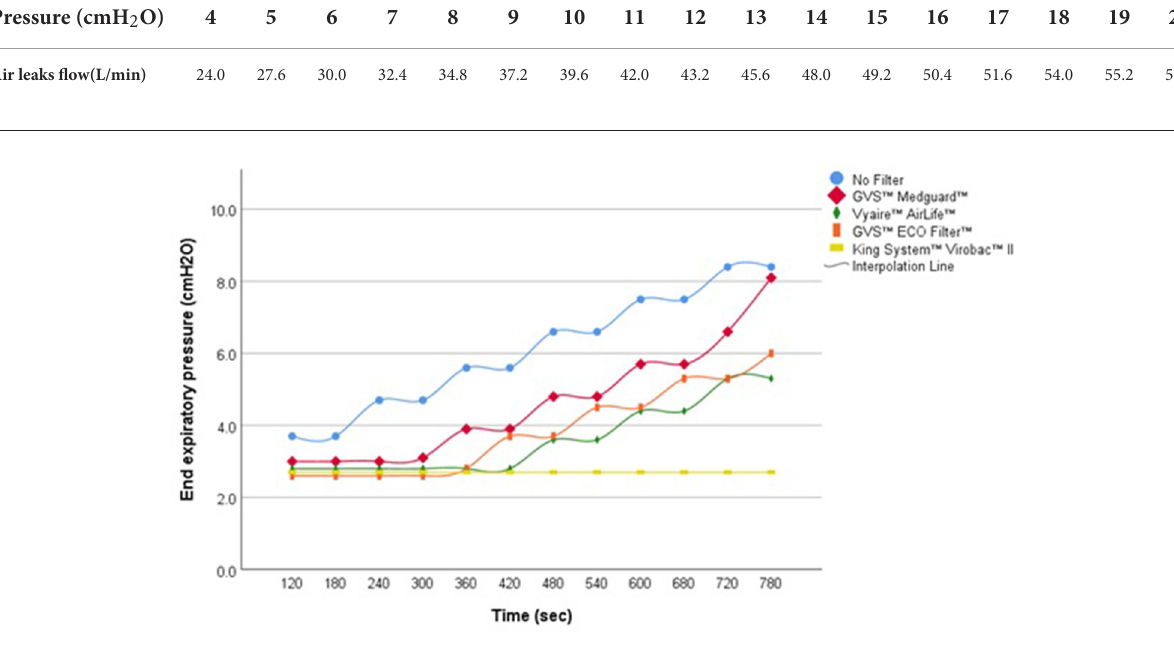
FIGURE2 Pressure variation in APAP mode during simulated apnea events, with UIAL.